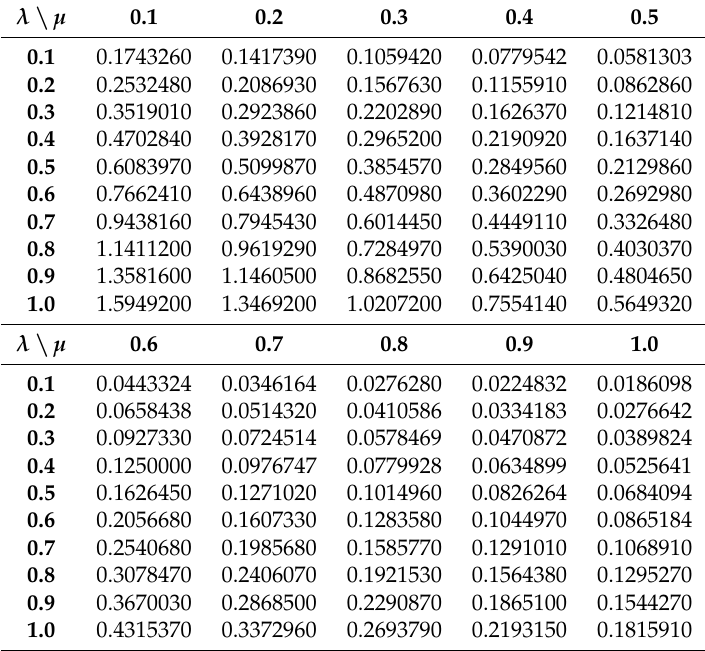
Table 3. Non-dimensional maximum axial displacement ¯ u ( 1/2 ) for the proposed NSG method in terms of the non-dimensional parameters λ and µ